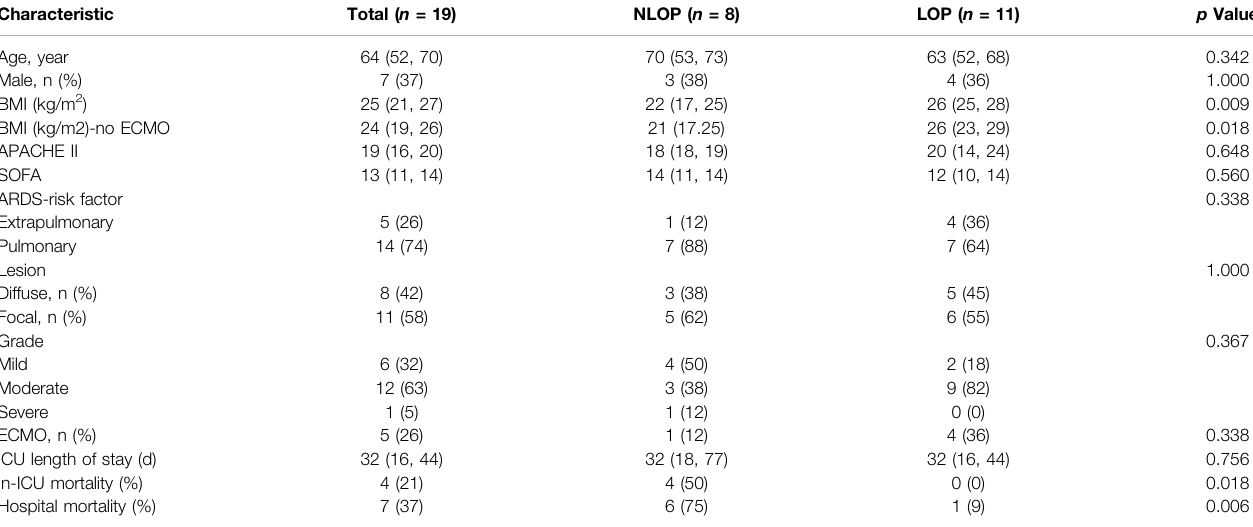
TABLE 1 | Characteristics and outcomes.